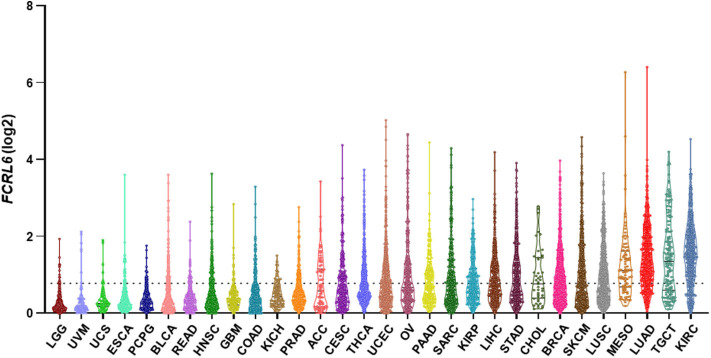
FCRL6 expression among various cancers. A violin plot demonstrating the expression (log2) of FCRL6 (ENSG00000181036) in non-hematopoietic cancers (n = 30) from The Cancer Genome Atlas (TCGA) (73). LGG, lower grade glioma (n = 529); UVM, uveal melanoma (n = 80); UCS, uterine carcinosarcoma (n = 56); ESCA, esophageal carcinoma (n = 173); PCPG, pheochromocytoma and paraganglioma (n = 186); BLCA, bladder carcinoma (n = 427); READ, rectum adenocarcinoma (n = 177); HNSC, head and neck squamous cell carcinoma (n = 546); GBM, glioblastoma (n = 174); COAD, colon adenocarcinoma (n = 499); KICH, kidney chromophobe (n = 89); PRAD, prostate adenocarcinoma (n = 548); ACC, adrenocortical carcinoma (n = 79); CESC, cervical squamous carcinoma (n = 309); THCA, thyroid carcinoma (n = 568); UCEC, uterine corpus endometrial carcinoma (n = 579); OV, ovarian serous cystadenocarcinoma (n = 379); PAAD, pancreatic adenocarcinoma (n = 182); SARC, sarcoma (n = 265); KIRP, kidney renal papillary cell carcinoma (n = 320); LIHC, liver hepatocellular carcinoma (n = 424); STAD, stomach adenocarcinoma (n = 407); CHOL, cholangiocarcinoma (n = 45); BRCA, breast carcinoma (n = 1,205); SKCM, skin cutaneous melanoma (n = 472); LUSC, lung squamous cell carcinoma (n = 551); MESO, mesothelioma (n = 86); LUAD, lung adenocarcinoma (n = 573); TGCT, testicular germ cell tumor (n = 156); and KIRC, kidney renal clear cell carcinoma (n = 599). The median and quartiles are demarcated (black lines) for samples in the plot of each cancer subtype. RPKM transcript data were downloaded from the R2: Genomics Analysis and Visualization Platform (http://r2.amc.nl), plotted using Prism software, and ordered by median values of expression. The dotted black line indicates the mean expression value (FCRL6 log2 = 0.78) of the 30 cancer subtypes. Note that THCA and cancers to the right on the plot exceed the mean.